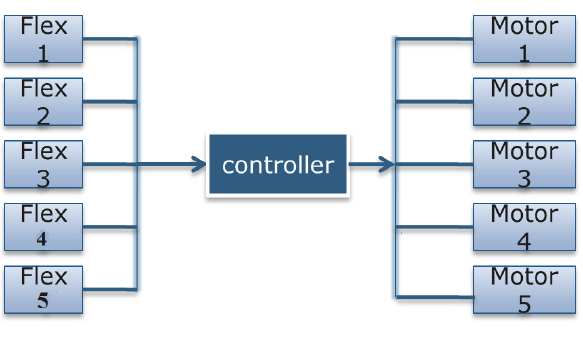
Figure 5: Block diagram of prosthetic